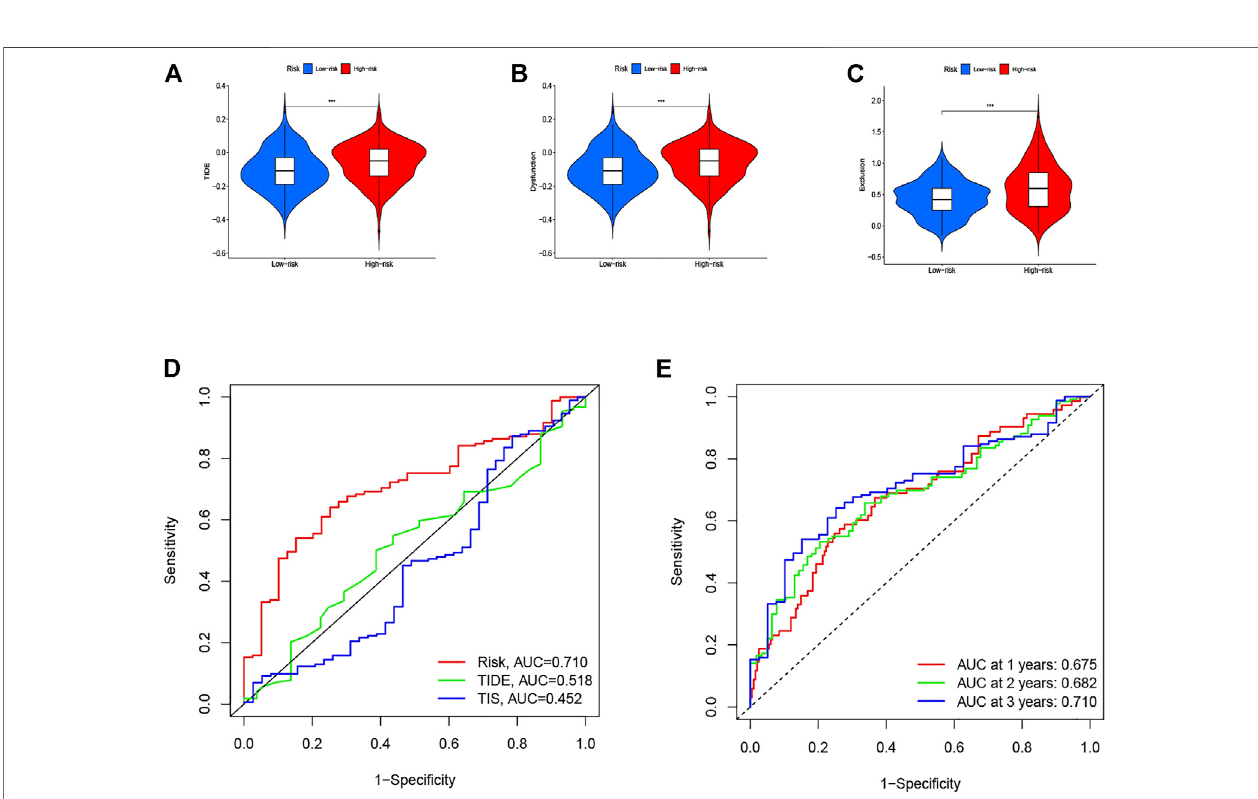
Frontiers in Genetics |